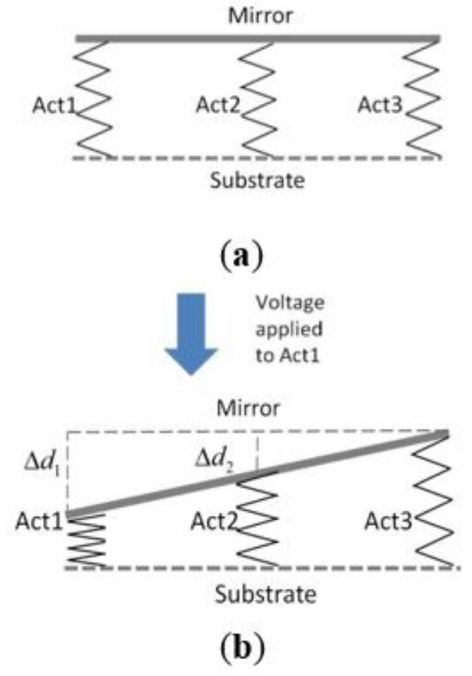
Figure 5. Cross-sectional view of the micro-mirror structure. ACT4 is placed behind ACT2: ( a ) no actuation and ( b ) voltage applied to ACT1 only. Act1 deforms by heat and produces height change ∆ d 1 . ACT2 and ACT4 will also have height change